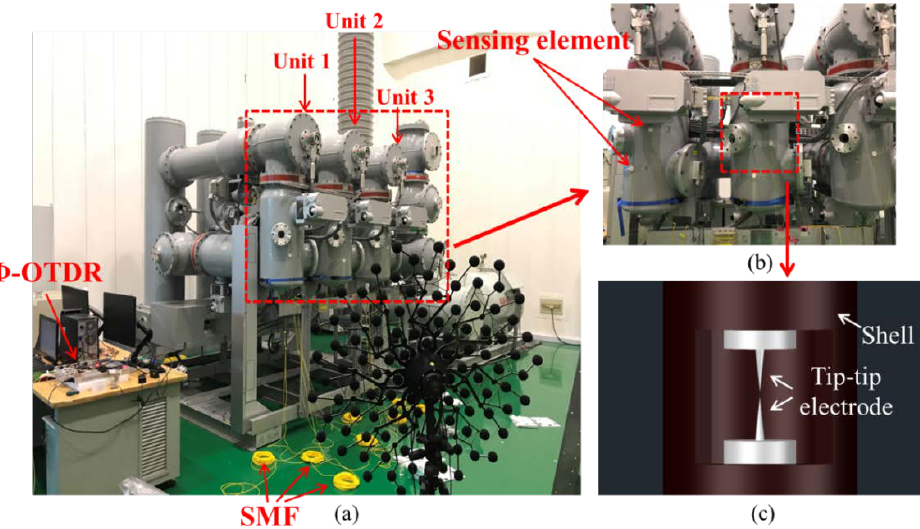
Figure 3. ( a ) GIS discharge defect simulation device; ( b ) attachments of the sensing elements on the outer surface of GIS shell; ( c ) and tip–tip electrode inside the GIS discharge defect simulation device.